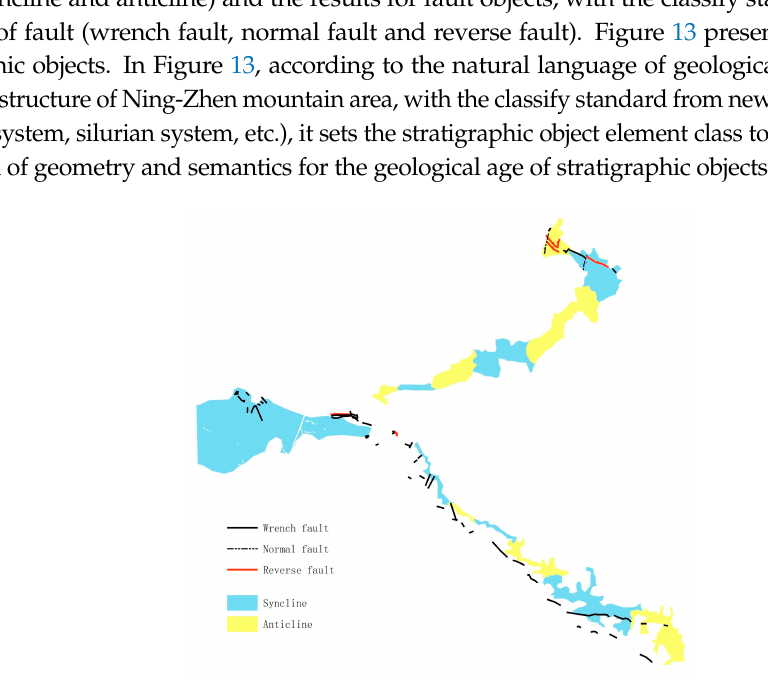
Figure 12. Modelling of fold and fault objects.